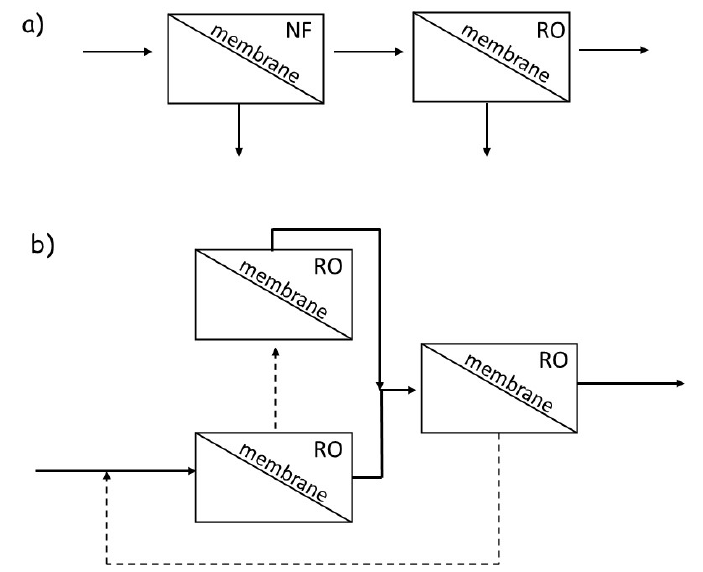
Figure 1. Membrane filtration spectrum. Adapted with permission from [31], copyright of Elsevier.